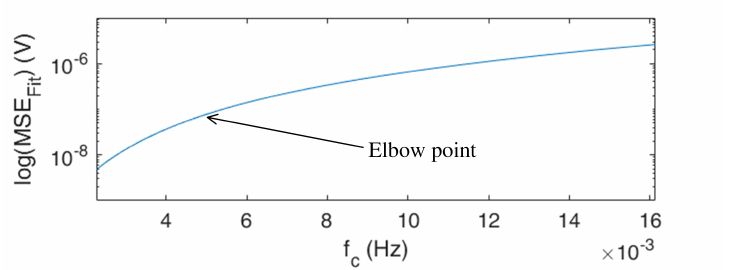
Figure 3. Phase I: Determine the initial cutoff frequency f c through cutoff frequency